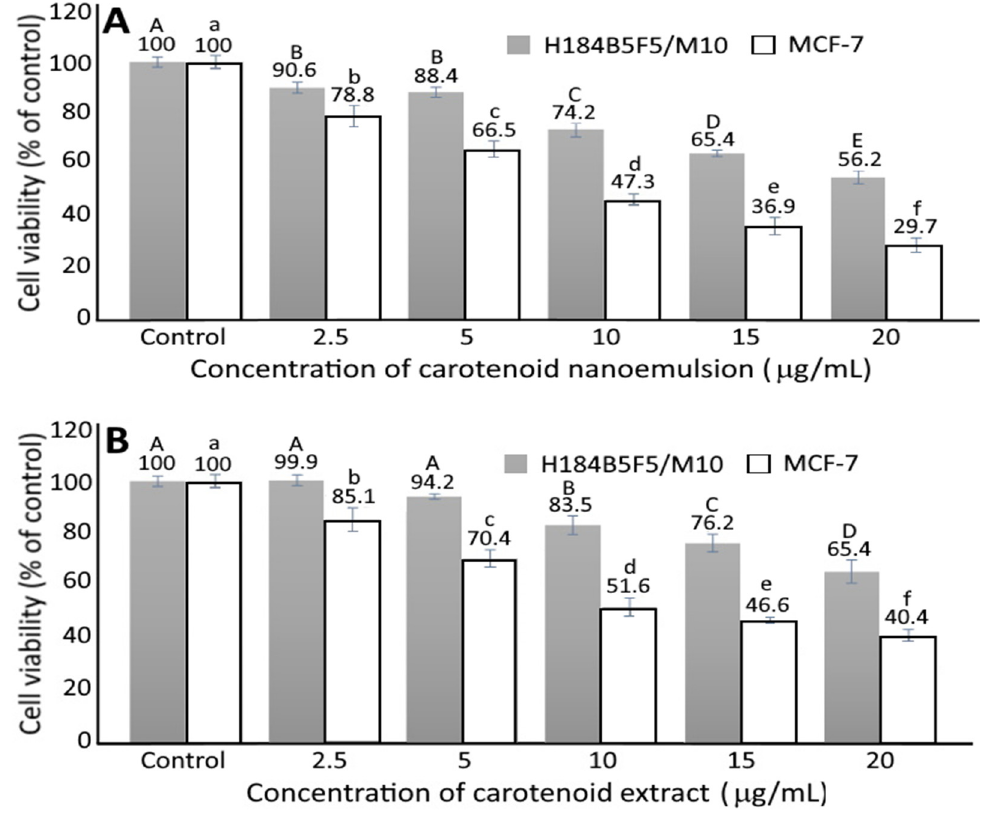
Figure 5. Effect of carotenoid nanoemulsions ( A ) and carotenoid extracts ( B ) on growth of human breast MCF-7 cancer cells and human mammary H184B5F5/M10 cells. Results are presented as mean ± standard deviation of triplicate independent experiments. Data with different capital letters (A– E) for H184B5F5/M10 cells and small letters (a–f) for MCF-7 cells are significantly different at p < 0.05.